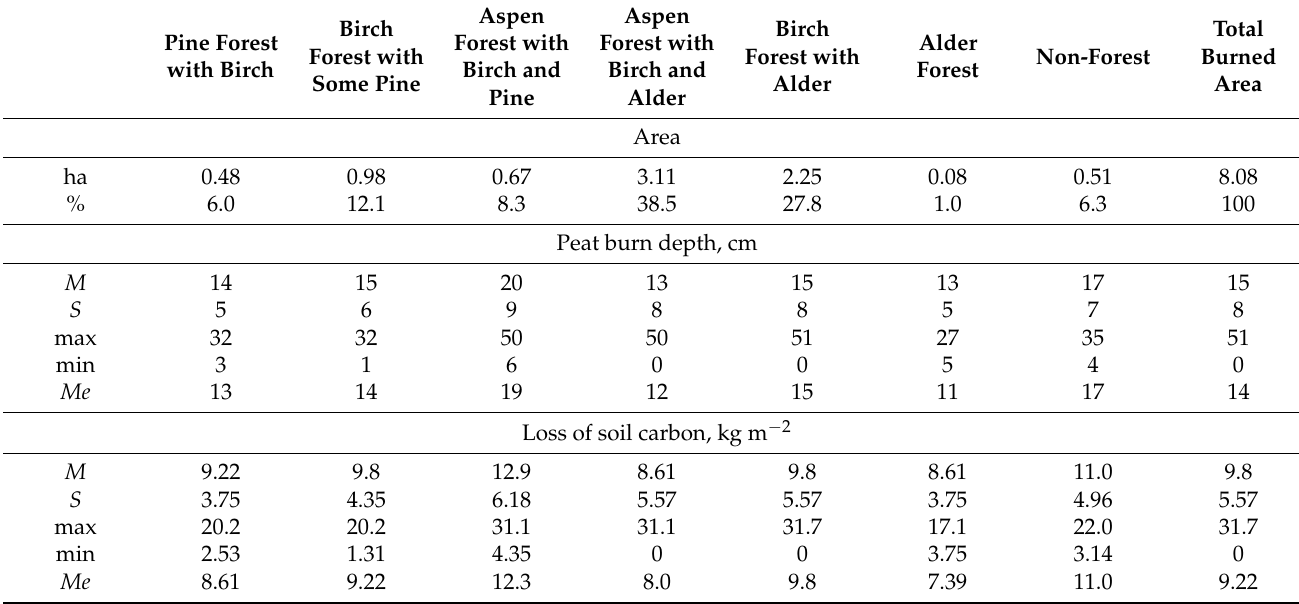
Figure 5. Peat burn depths (m) ( left ) and loss of soil carbon (kg m − 2 ) ( right ). Table 2. Peat burn depths and loss of soil carbon in different thematic classes. M , arithmetic mean; S , standard deviation; Me ,